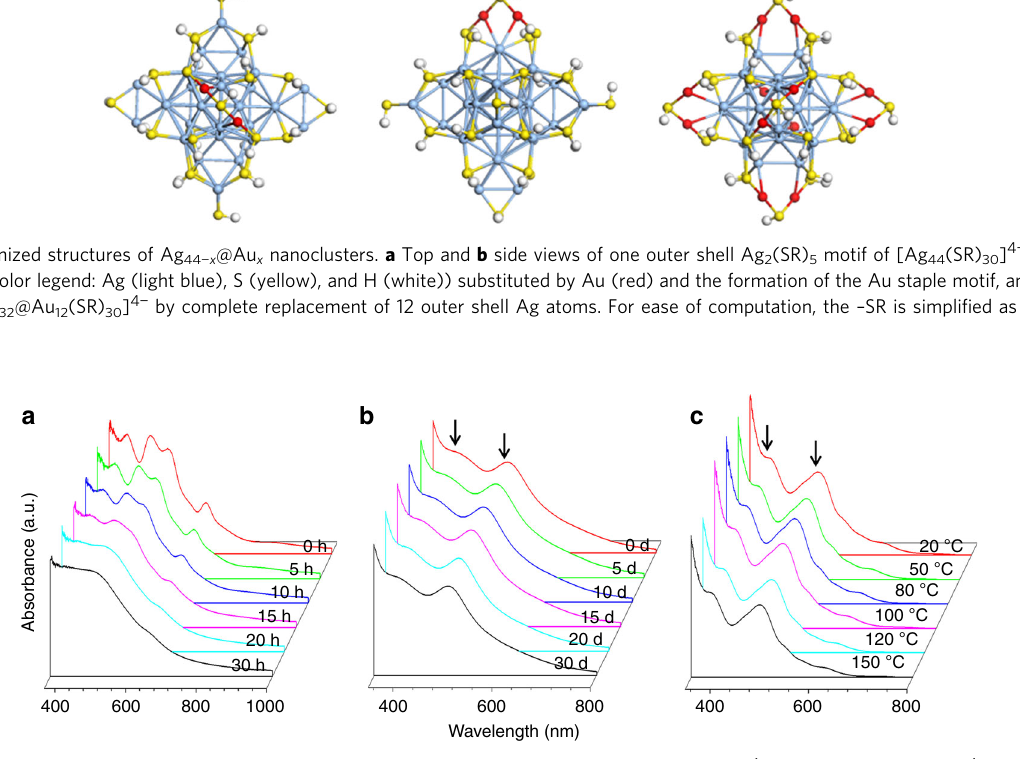
Fig. 9 Enhanced stability of Ag@Au nanoclusters. Ultraviolet – visible absorption spectra of a [Ag 44 (SR) 30 ] 4 − and b , c [Ag 32 Au 12 L 30 ] 4 − nanoclusters incubated in an elongated period ( a , b , at room temperature) and at varied temperature ( c , incubation time = 2 h). The ligand (L) is thiolate (SR) or halogen (e.g., Cl). The arrows in b , c indicate the absorption features of [Ag 32 Au 12 L 30 ] 4 − at 390 and 490 nm. Clusters in a , b were dissolved in 1 wt.% CsOH aqueous solution, while those in c were dissolved in (Fig. 9), the as-synthesized [Ag 32 Au 12 L 30 ] 4 − NCs were stable